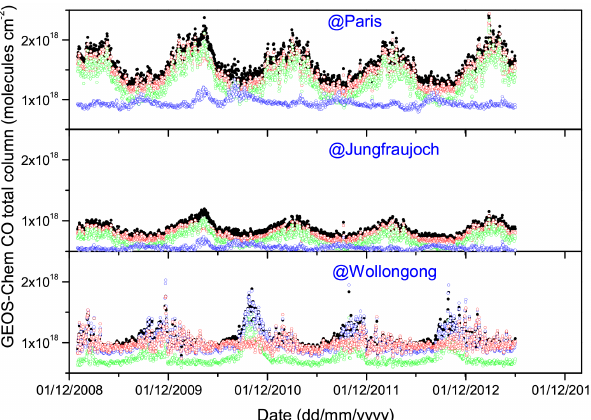
Figure 8. GEOS-Chem time series of CO total columns for Paris (top), Jungfraujoch (middle) and Wollongong (bottom). Different colours indicate standard run (black), run without biomass burning (red), run without biogenic emissions (green) and run without an- thropogenic emissions